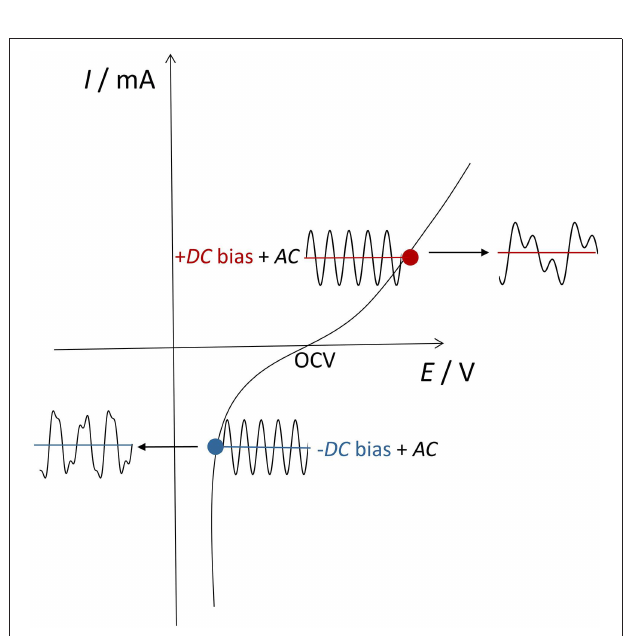
FIGURE 3 | Overview of the NLEIS